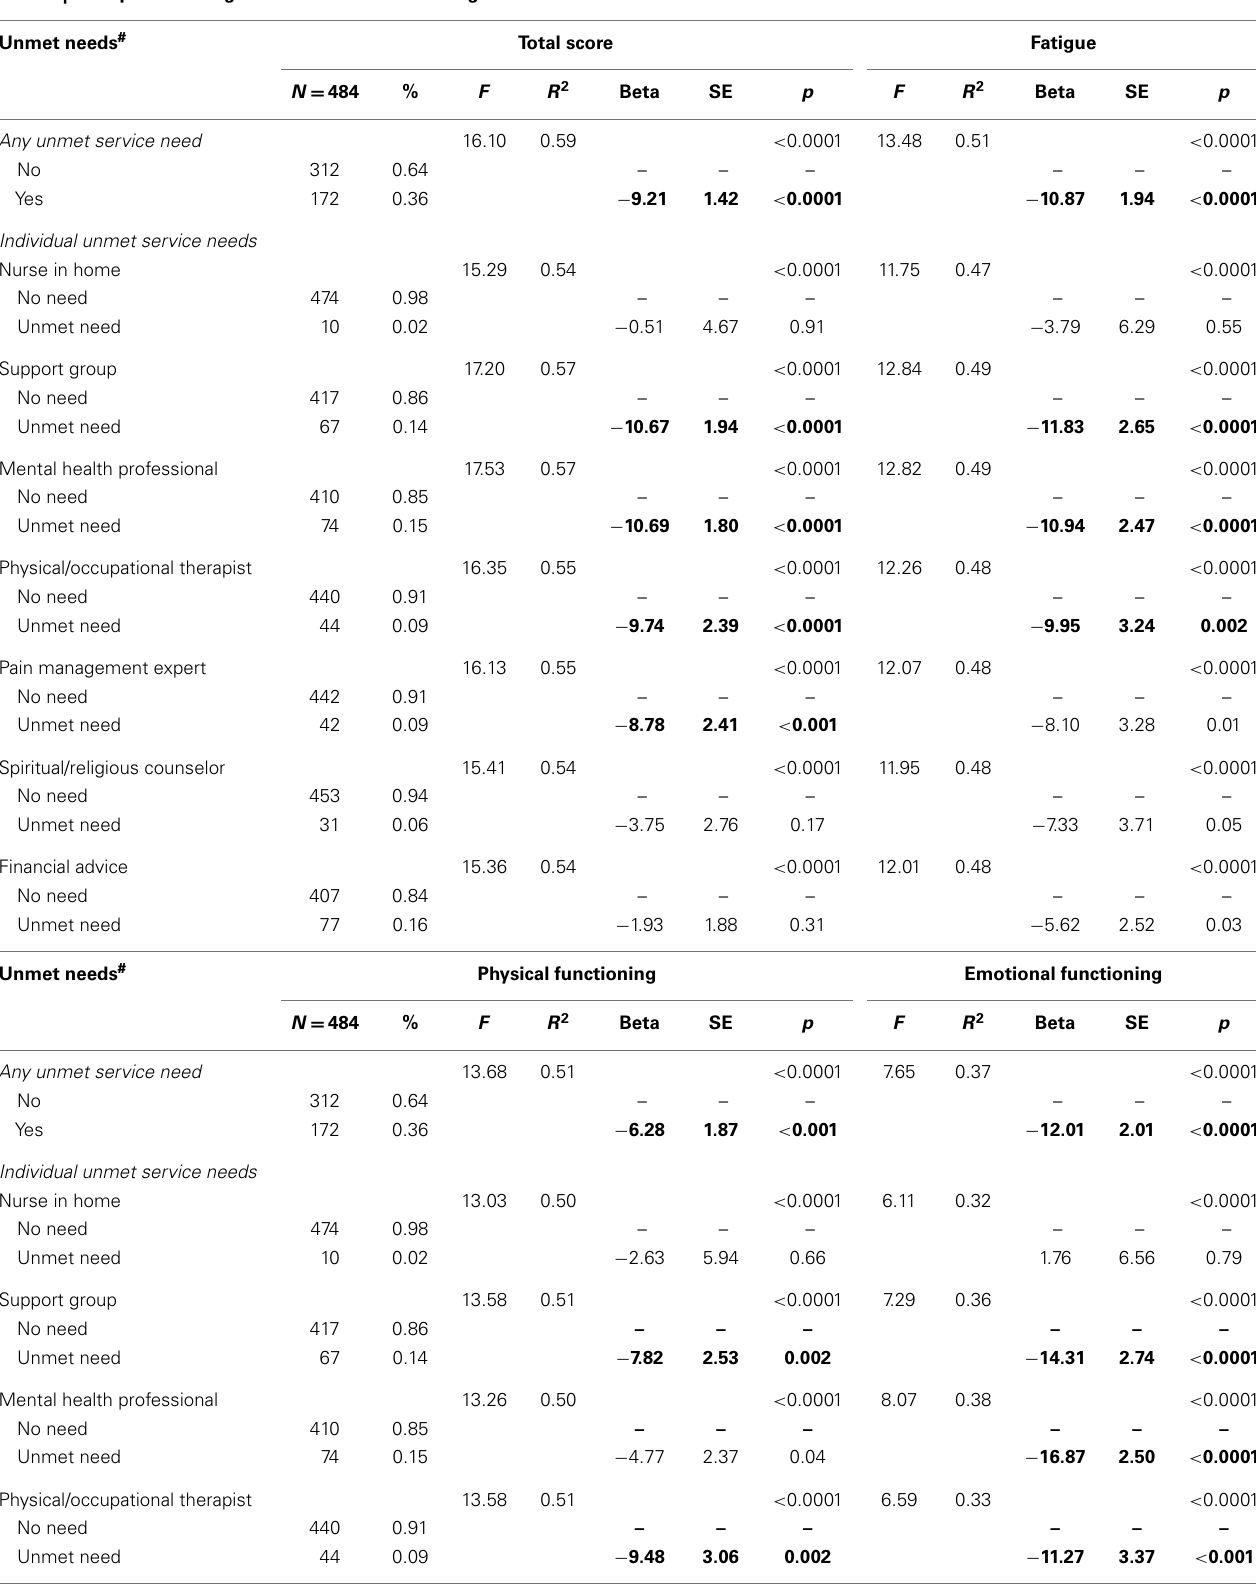
Table 2 | Multiple linear regression models* examining unmet service needs and PedsQL